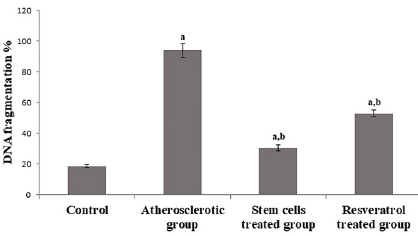
Figure 4. DNA fragmentation (%) in rats experimentally induced with atherosclerosis and treated with stem cells or resveratrol.